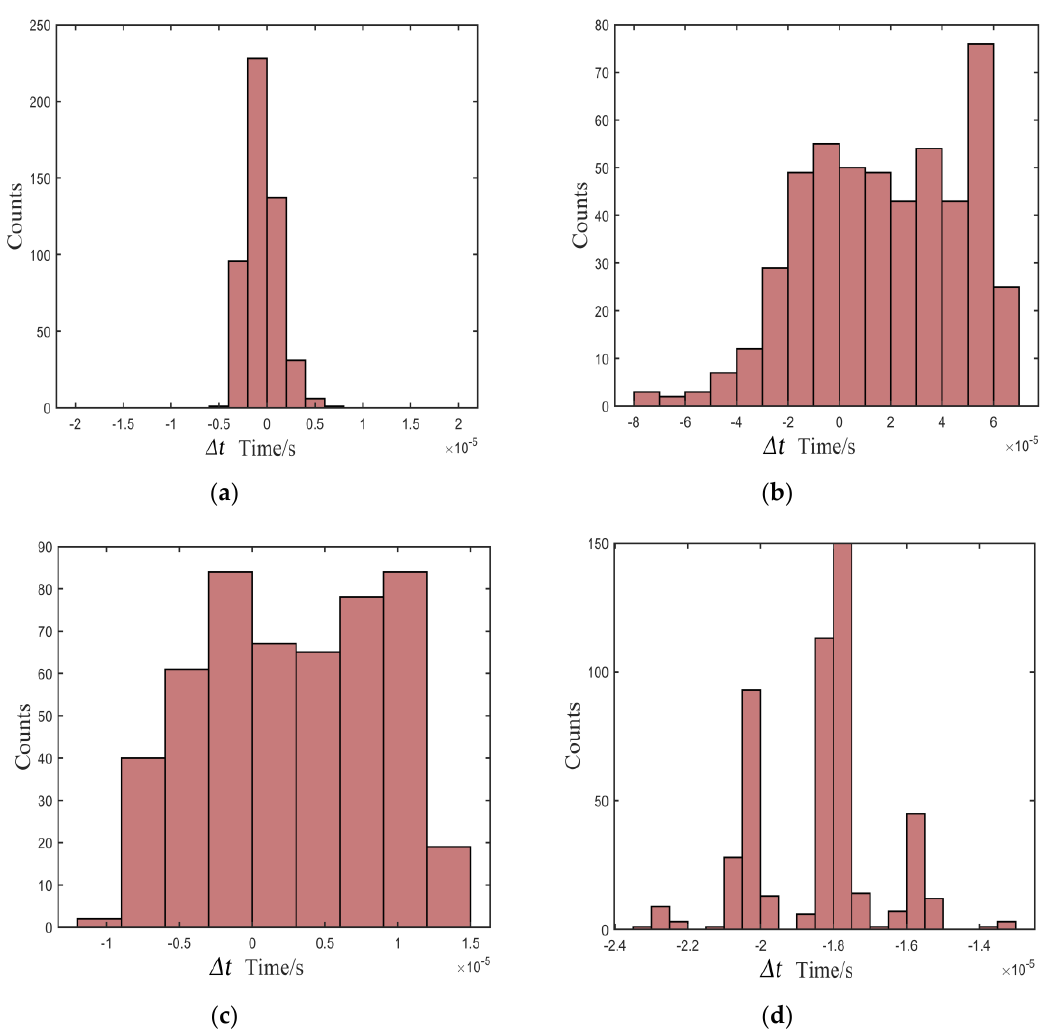
Figure 8. Distribution of deviation in the environment of 5 dB: ( a ) proposed, ( b ) Kurz, ( c ) TKEO, and ( d ) high-order statistics methods.